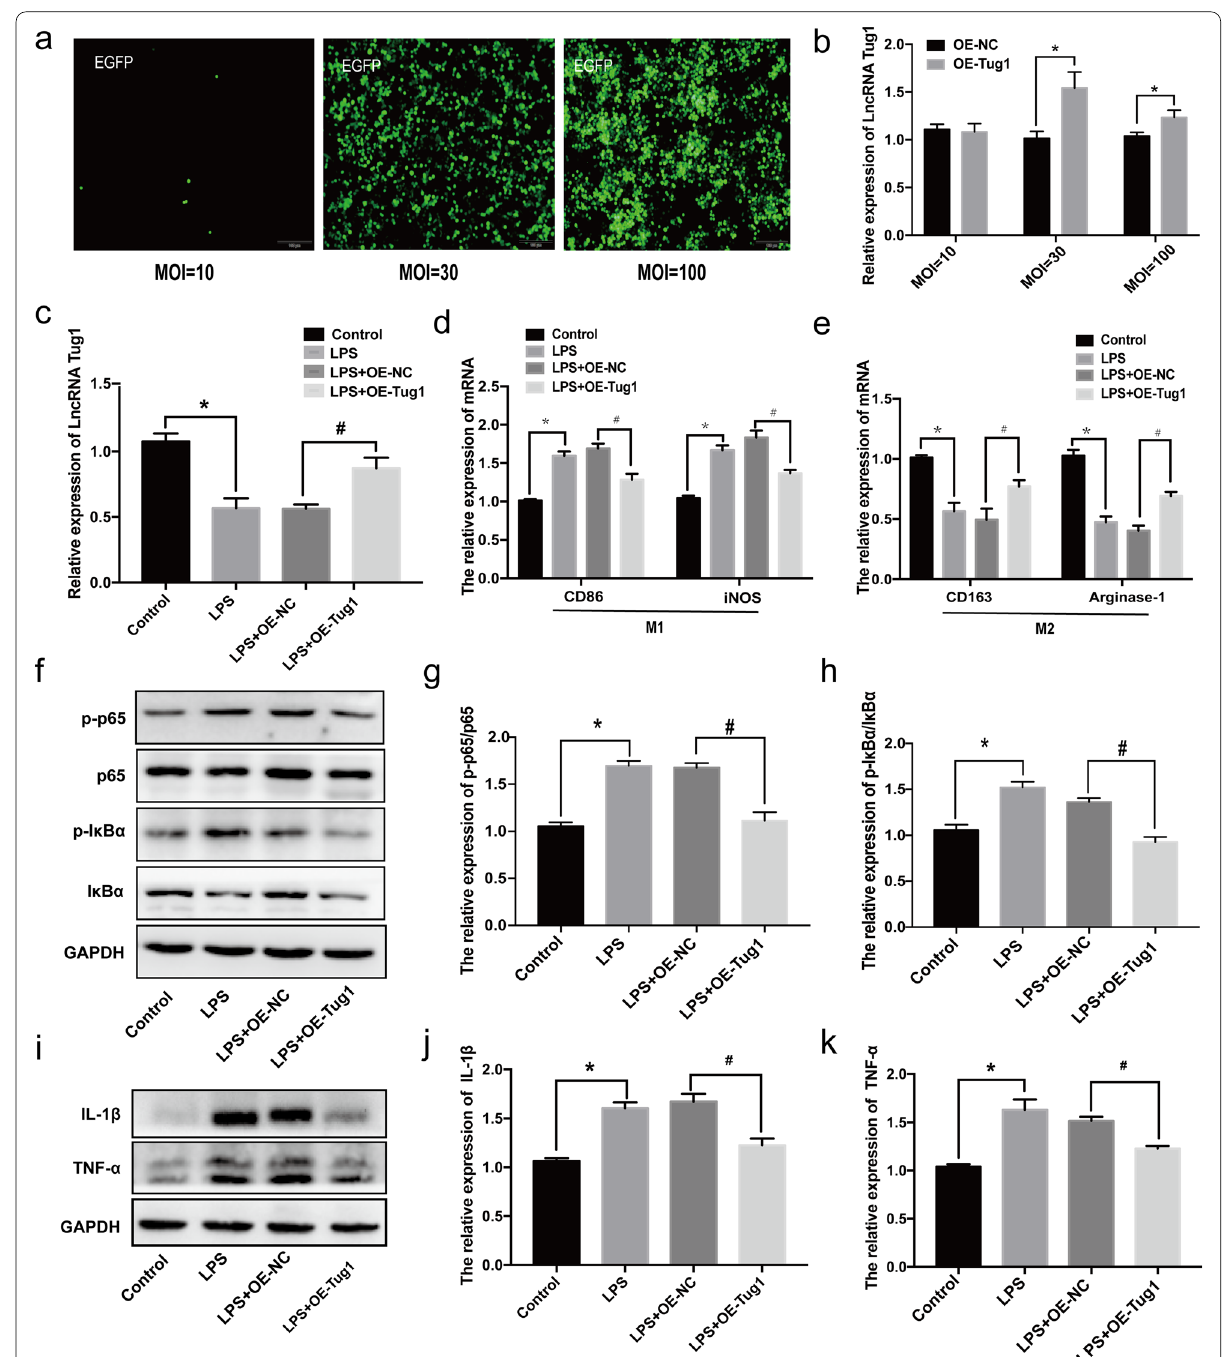
Fig. 4 Effect of Tug1 overexpression on LPS-induced inflammation in microglia. a Rat microglia infected with green fluorescence-labeled adenovirus. b Transfection efficiency of lncRNA Tug1 overexpression adenovirus at different multiplicities of infection. c Overexpression of lncRNA Tug1 in microglia. d The level of M1-associated markers mRNA in microglia cells. e The mRNA of M2-associated markers CD163 and Arginase-1 in rat microglia. f Protein bands of p-p65, p65, p- Ι κ Β α and Iκ Β α in rat microglia. g‑h The relative level of p-p65/p65 and p- Ι κ Β α/ Ι κ Β α. i Protein bands of IL-1β and TNF-α in rat microglia. j‑k The relative protein level of IL-1β and TNF-α. (* P < 0.05, ** P < 0.01 vs. Control; # P < 0.05, ## P < 0.01 vs. LPS